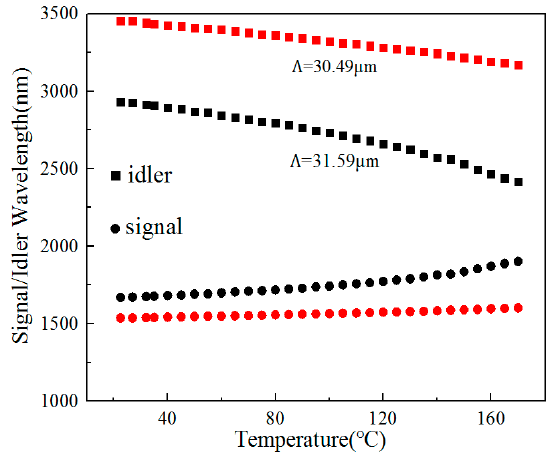
Figure 2. The output wavelength of the module as a function of the crystal temperature.